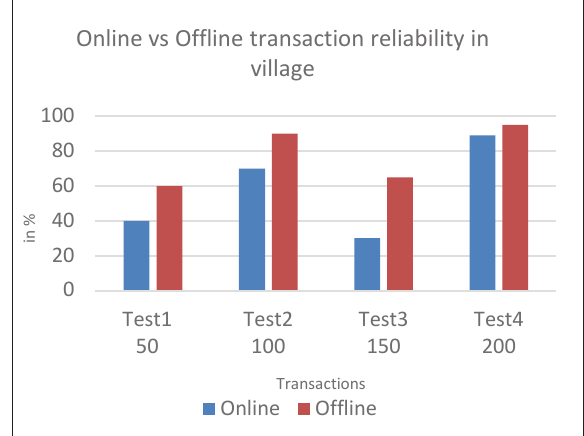
Fig. 4. Average Success